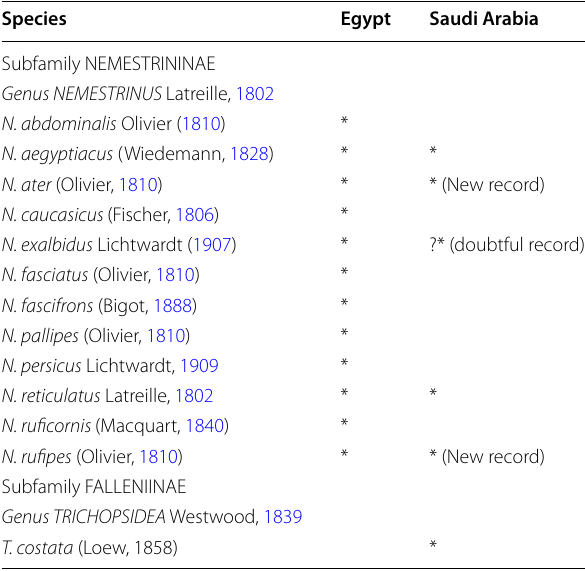
Table 1 List of species of the family Nemestrinidae in Egypt